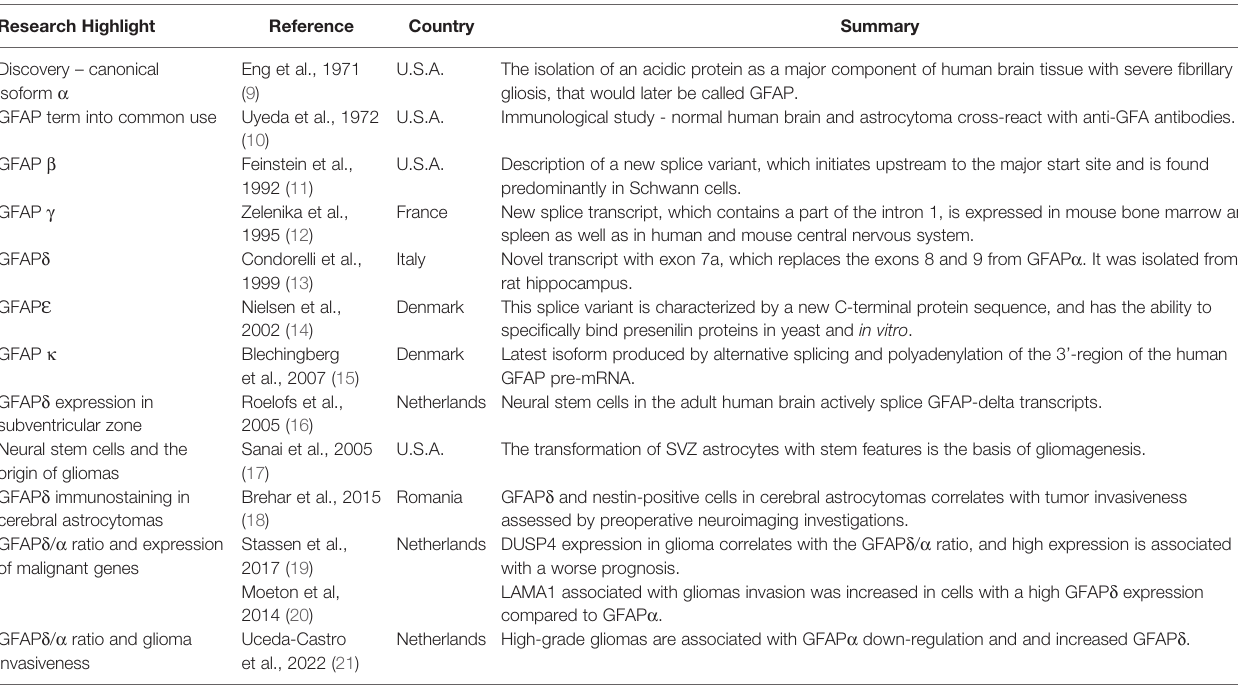
TABLE 1 | Research on GFAP related to the invasiveness of cerebral